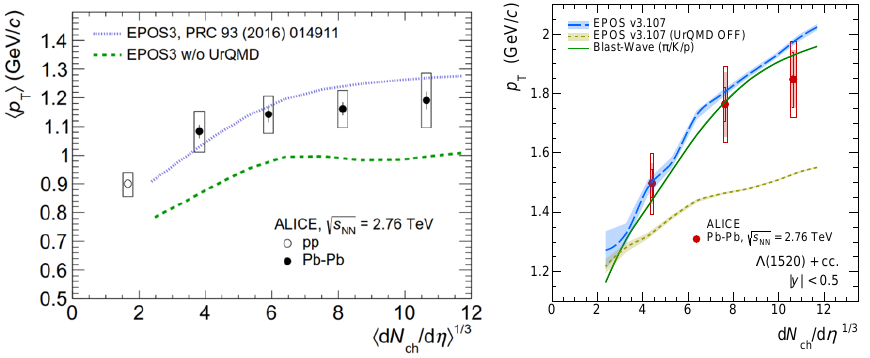
Figure 3. (color online) The mean transverse momentum of ρ 0 (left) [2] and Λ ∗ (right) [7] as a function of the charged-particle multiplicity density. The measurements are also compared to model predictions: EPOS3 [11], Blast-Wave